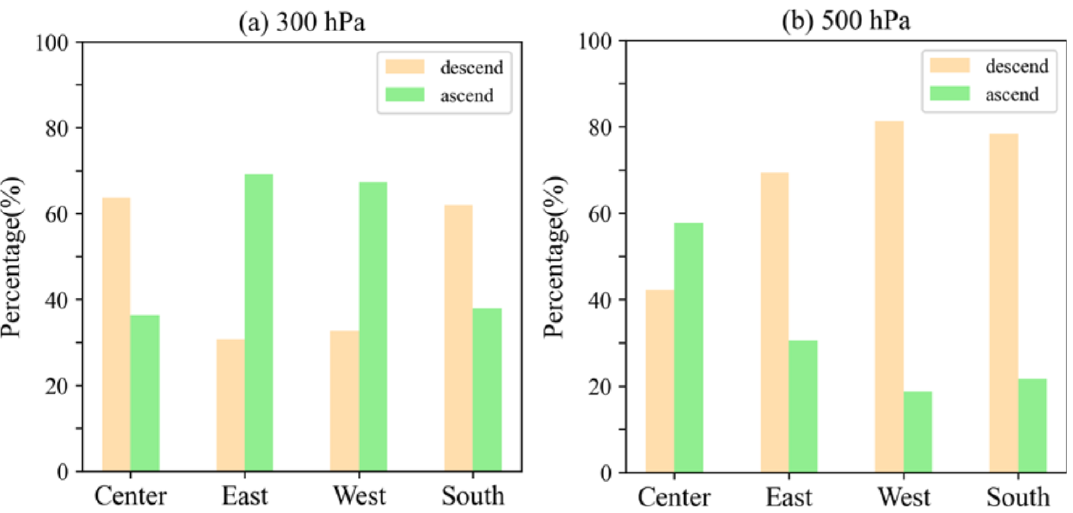
Figure 9. Percentages of descending and ascending air parcels for each part at 300 hPa ( a ) and 500 hPa ( b